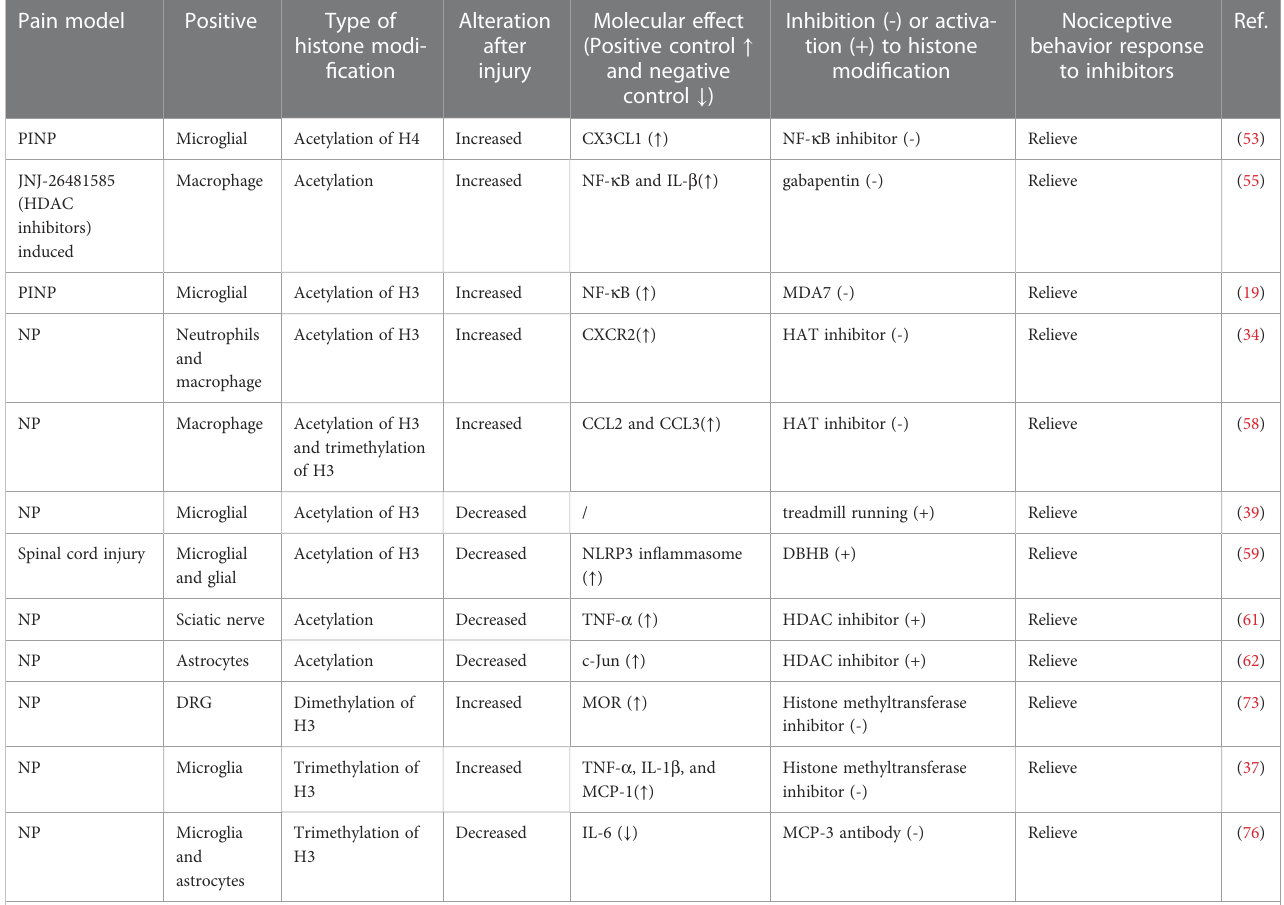
TABLE 1 Roles of histone modi fi cation in chronic in rodent